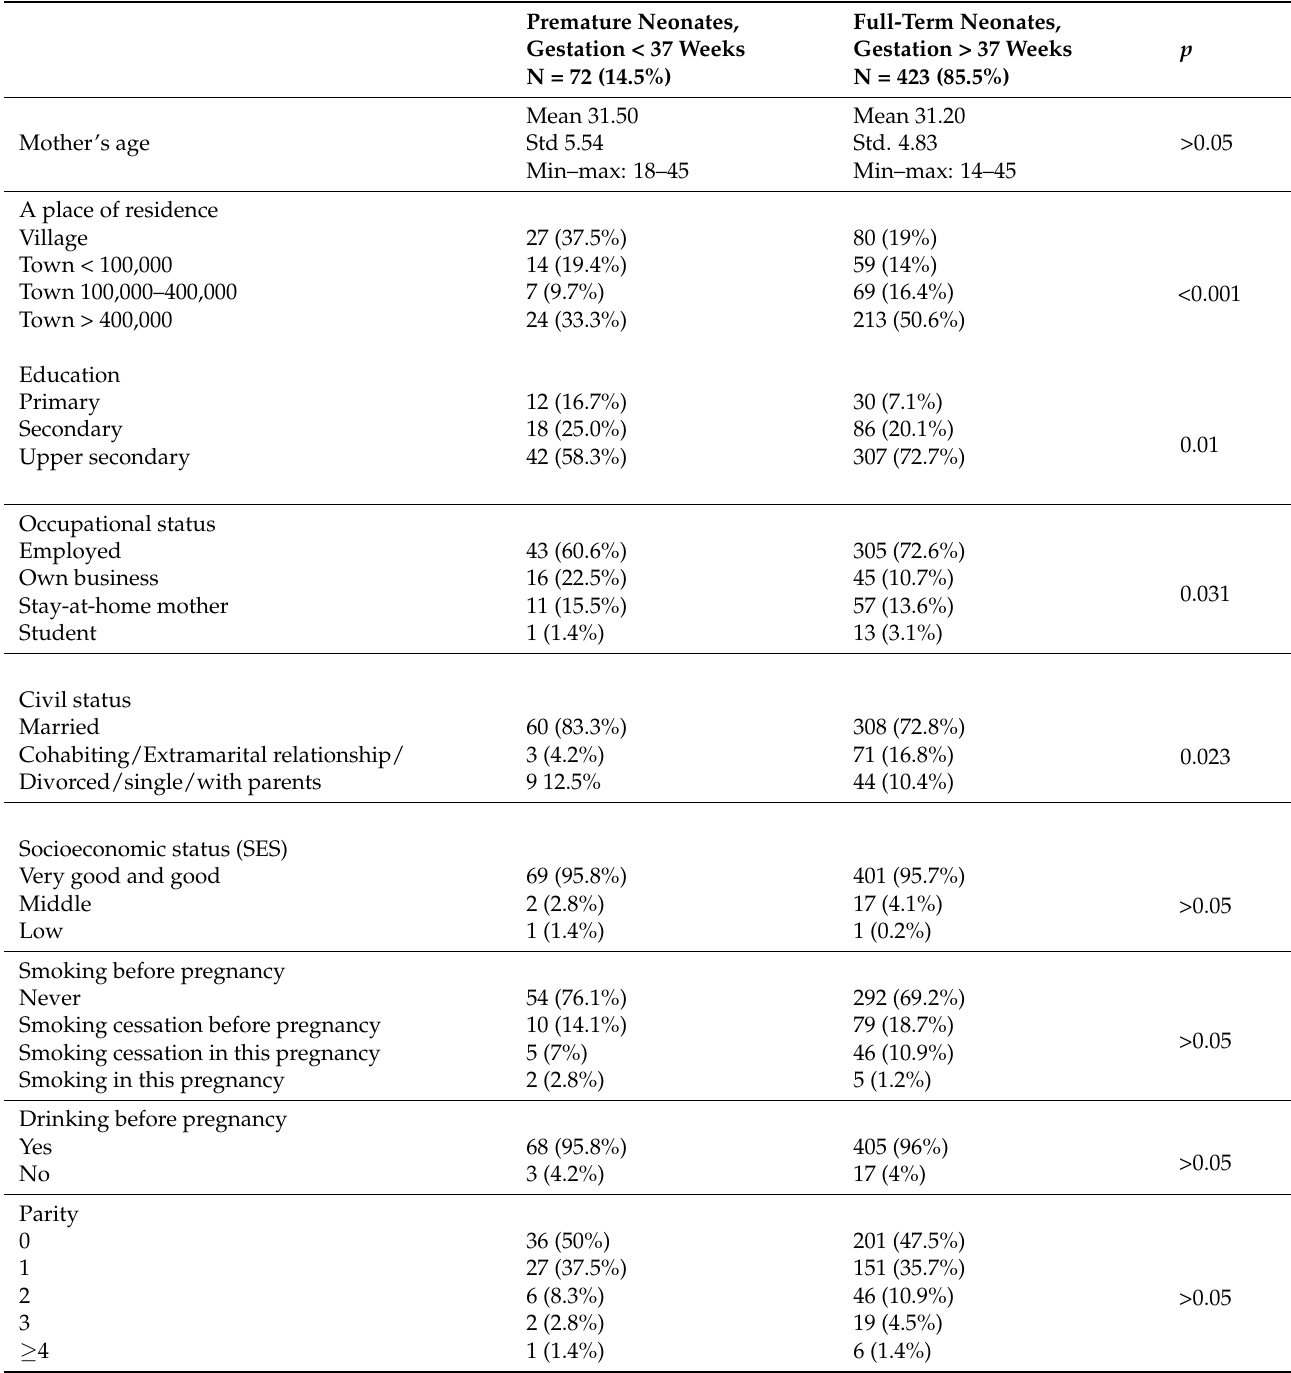
Table 1. Characteristics of the study population, n =